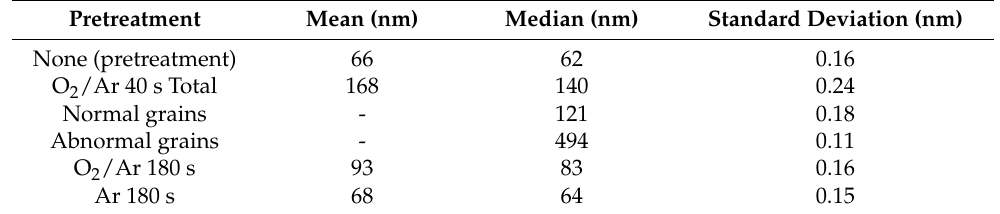
Table 2. Grain size